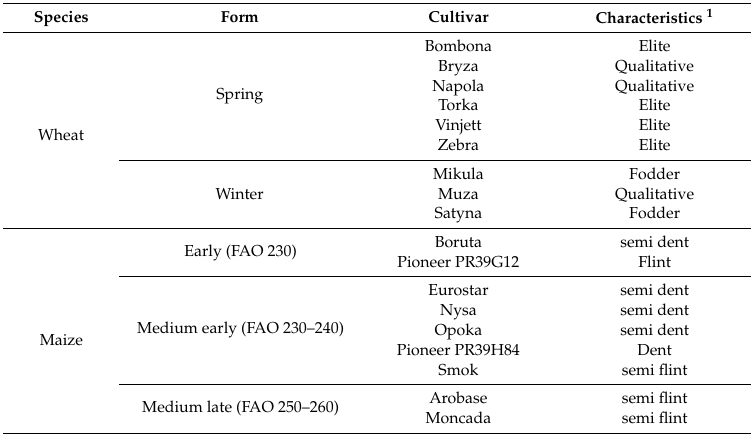
Table 1. Description of wheat and maize